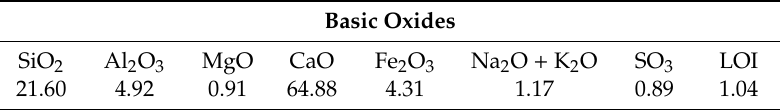
Table 3. Chemical composition of the Portland cement clinker, mass%.